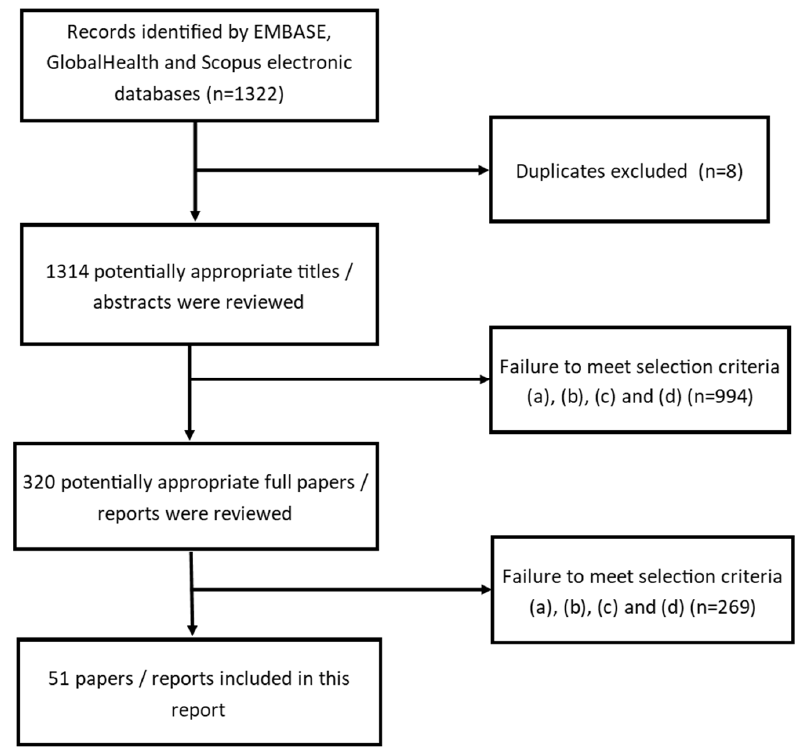
Figure 1. A flow chart illustrating the initial systematic literature search process.